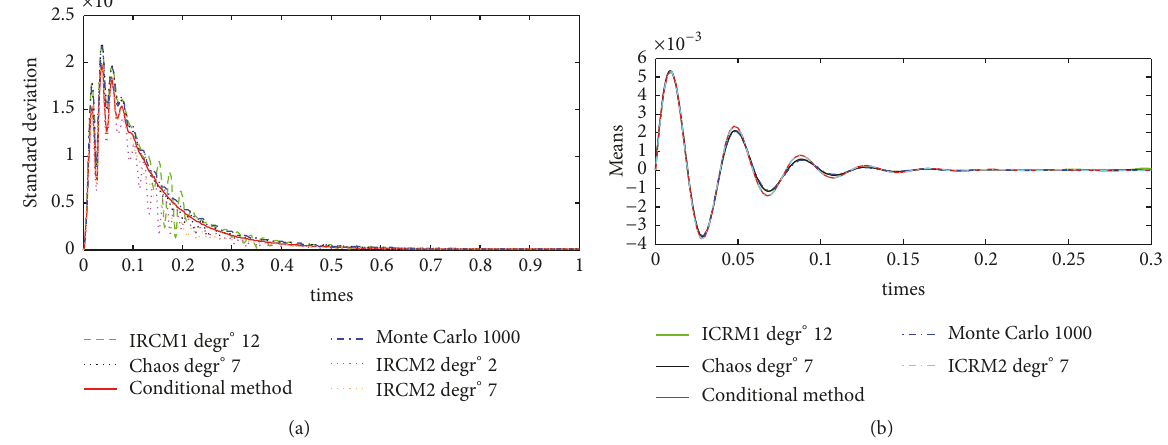
Figure 4: (a) Standard deviation of 𝑈 when 𝜉 𝑖 follow the truncated exponential law in [0, 10] and 𝜎 𝑖 = 20%. (b) Means of 𝑈 when 𝜉 𝑖 follow the truncated exponential law in [0,10] and 𝜎 𝑖 =